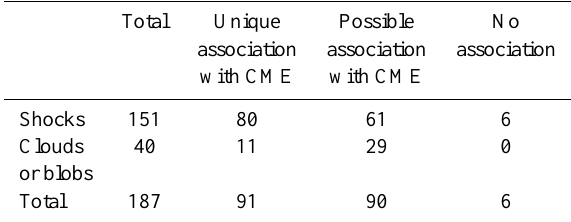
Table 3. Association of ICME events with their potential CME sources. Total Unique Possible No association association association with CME with CME Shocks 151 80 61 6 Clouds 40 11 29 0 or blobs Total 187 91 90